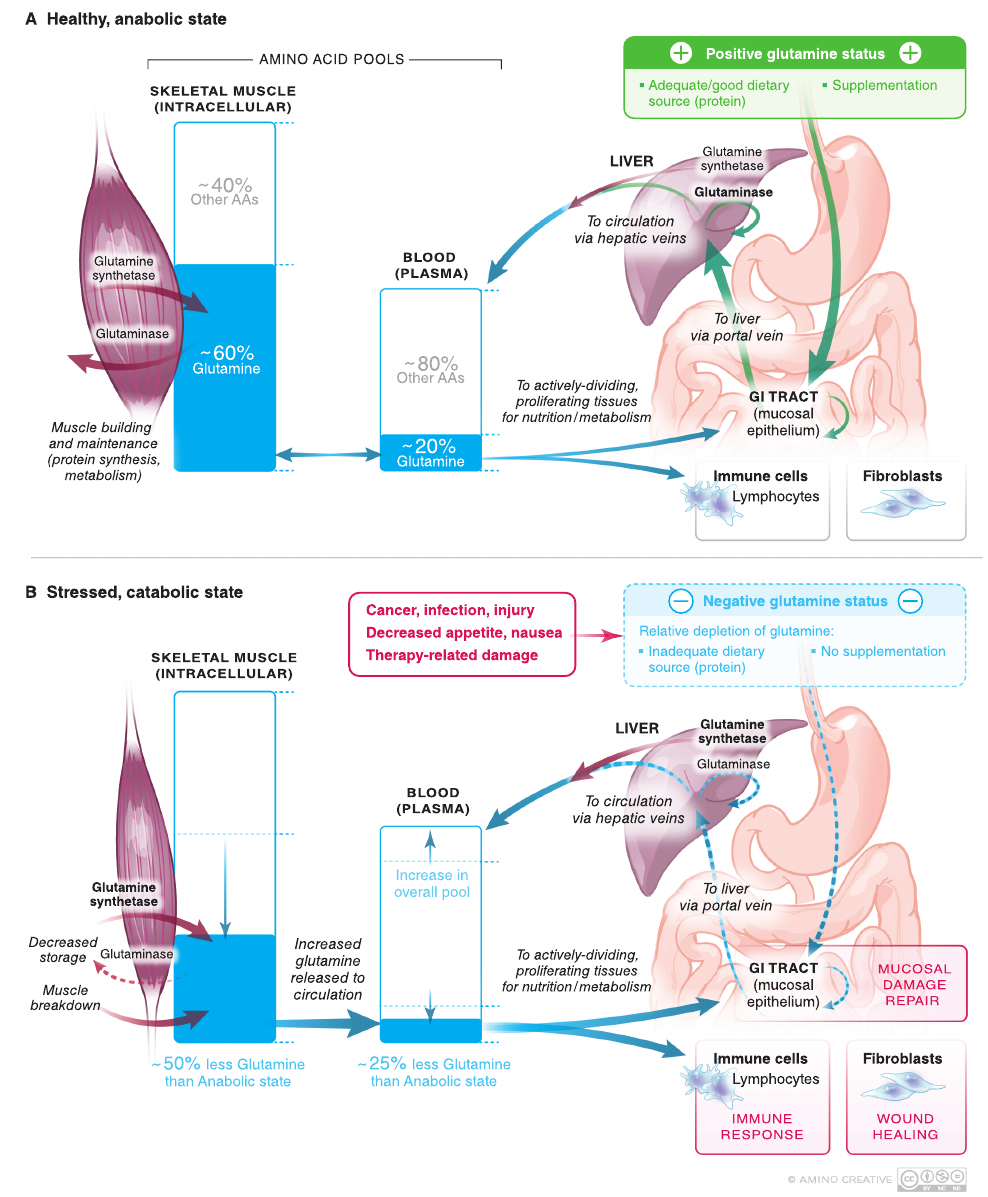
Figure 2. Pivotal role of glutamine stored in muscle (glutamine “bank”), normal high glutamine concentration in plasma, and liver amino acid metabolism (switch hitter) to facilitate steady state glutamine for mucosal health in ( A ) healthy anabolic state versus ( B ) during catabolic states including injury from cancer therapy, malnutrition, and tissue damage. In the catabolic state of mucositis from cancer therapy injury, topical glutamine + disaccharide can be